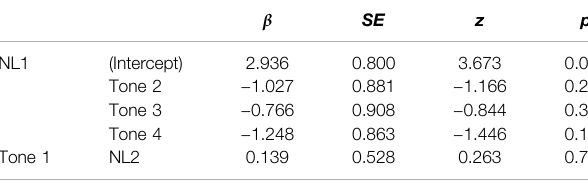
TABLE 5 | Descriptive results for tone effects.